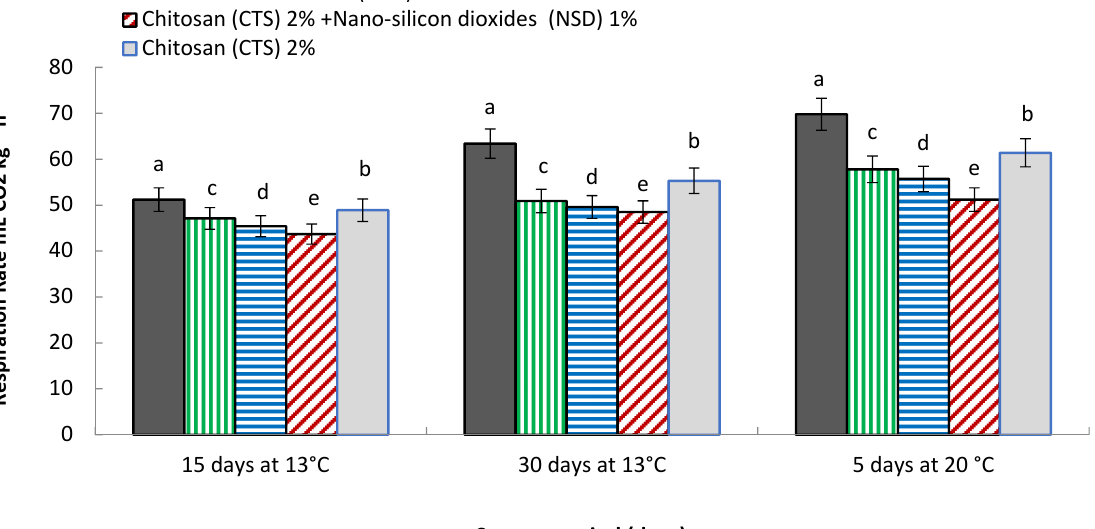
Figure 6. Respiration rate mL CO2 kg − 1 h − 1 as a mean of ‘Tommy Atkins’ mangoes from two seasons, stored at 13 ± 1 °C and 90–95% RH for 30 days. Afterward, the fruits were stored at 20 ± 2 °C and 70–75% RH for 5 days as the marketing period. Vertical bars indicate the standard error (SE) of the mean ( n = 5). The superscript letters followed by the same letters are not significantly different according to Duncan’s multiple range test at 0.05 level.